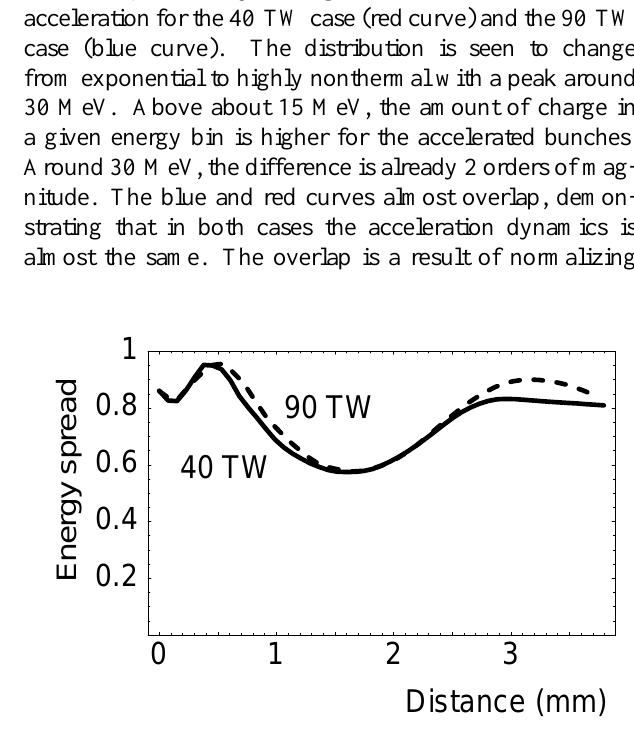
FIG. 16. Relative energy spread as a function of propagation distance for the 40 TW case and the 90 TW case.